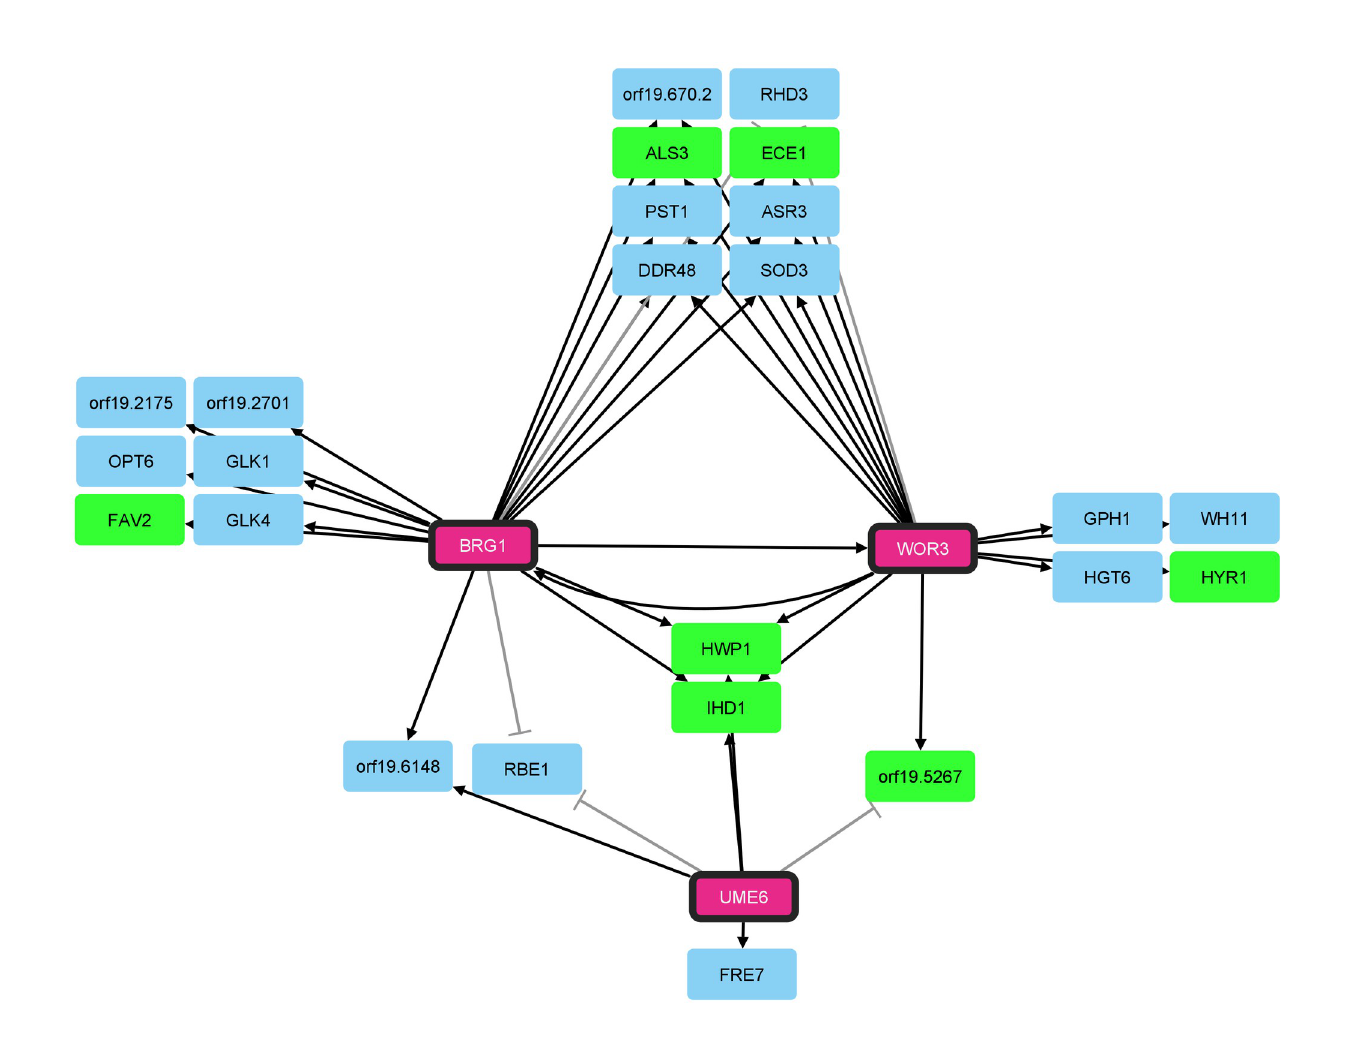
Fig 11. Reinforcement and extension of the Efg1 principal network by BRG1 , UME6 , and WOR3 . Network of Efg1 direct target transcription factor interactions with other principal Efg1 direct targets (green) and Efg1 indirect targets (blue). Arrows represent conserved activation by the TDH3-TF allele in the SC5314, P87, and P75010 efg1 Δ / Δ strain backgrounds. Blunt-end connections represent repression by the TDH3-TF allele in all three clinical isolate efg1 Δ / Δ backgrounds. Bolded arrows represent conserved activation among all three clinical isolate efg1 Δ / Δ backgrounds of a principal Efg1 direct target TF by one of the other principal Efg1 direct target TFs. Network relationships were deduced from one set of growth conditions and three diverse C . albicans strain